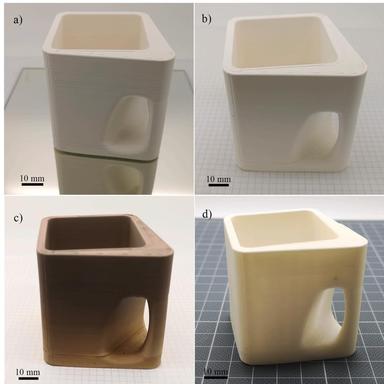
Optical analysis of the cup printed using Fabru YSZ filament after a) printing, b) solvent debinding, c) wick debinding, and d) sintering.